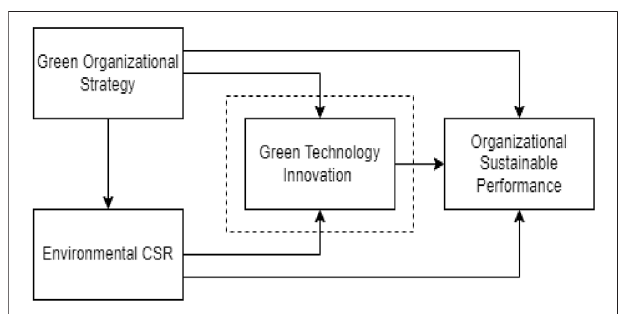
FIGURE 1 | Conceptual framework of the